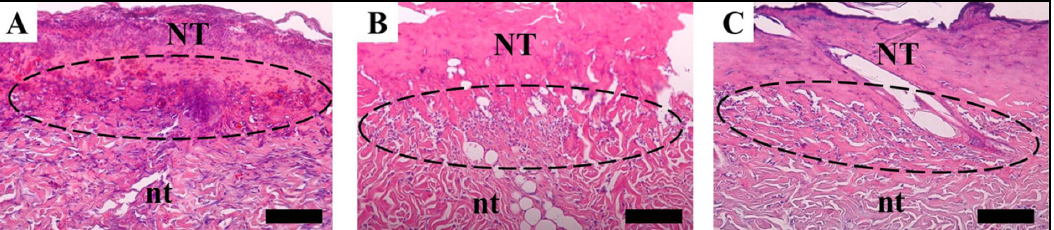
Figure 6. Photos of burn wound tissues stained with H&E at 7, 14, and 21 days. ( A ) Hospital gauze (14 days), ( B ) SF nanomatrix (7 days), and ( C ) Medifoam ® (7 days). (Scale: 50 µm, NT: necrosis tissue, nt: natural tissue, circle: Keratinocytes). Reprinted with permission from reference [157].